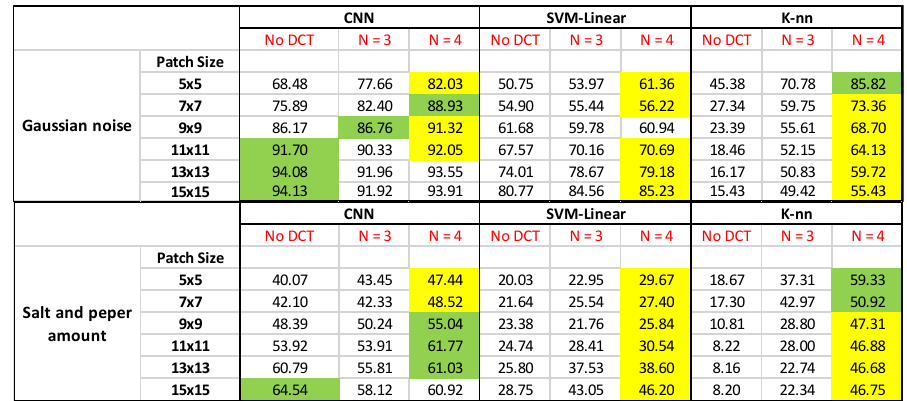
Figure 2: Indian Pines Dataset: Classification accuracy rates for CNN, SVM and k-NN based approaches, for Gaussian and Salt & Pepper noise, for different patch sizes and different numbers of zeroed high-frequency DCT coefficients. Yellow-coloured rates show the best performing configuration per technique, and green- coloured rates the best performing one among all techniques for the given patch